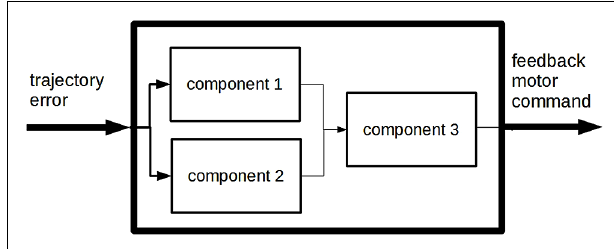
FIGURE 2 |A model of the “feedback controller” component of the BA